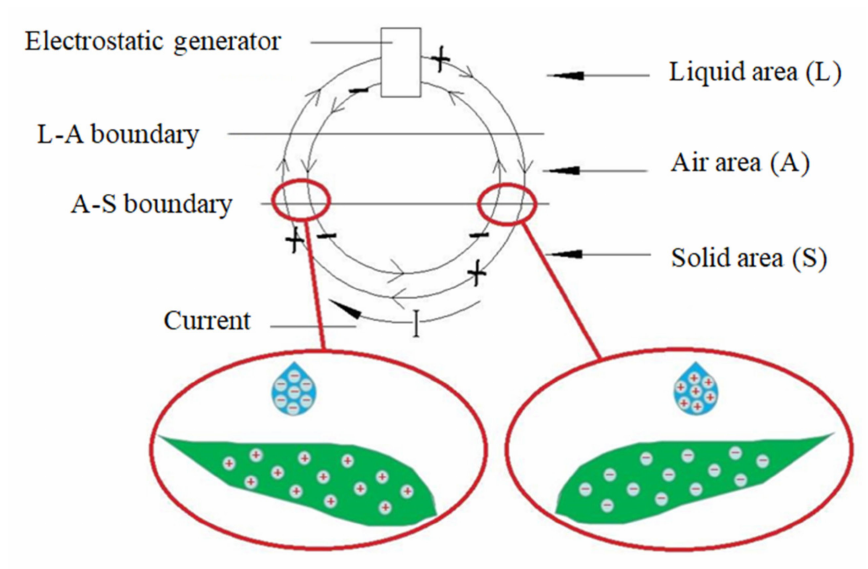
Figure 4. Electrostatics physical model of aerial electrostatic spraying based on charge transfer space loop